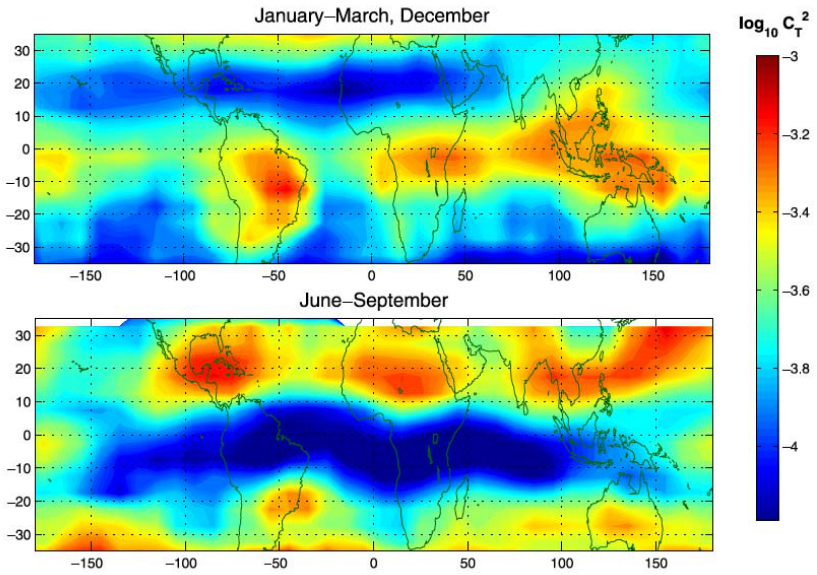
Fig. 53. C T2 (K 2 m -2/3 ) at 42 km for Jan–March (top), Dec. and for June–Sept. (bottom), logarithmic Fig. 53. C 2 (K 2 m − 2 / 3 ) at 42km for January–March (top), Dec and for June–September (bottom), logarithmic color scale. The data are T color scale. The data are averaged in 5°x10° latitude-longitude bins and a three-point smoothing is averaged in 5 ◦ × 10 ◦ latitude-longitude bins and a three-point smoothing is applied to the obtained fields. In order to make these maps more applied to the obtained fields. In order to make these maps more contrasting, the color scale covers one contrasting, the color scale covers one decade only (from Gurvich et al., 2007). decade only (from Gurvich et al., 2007).